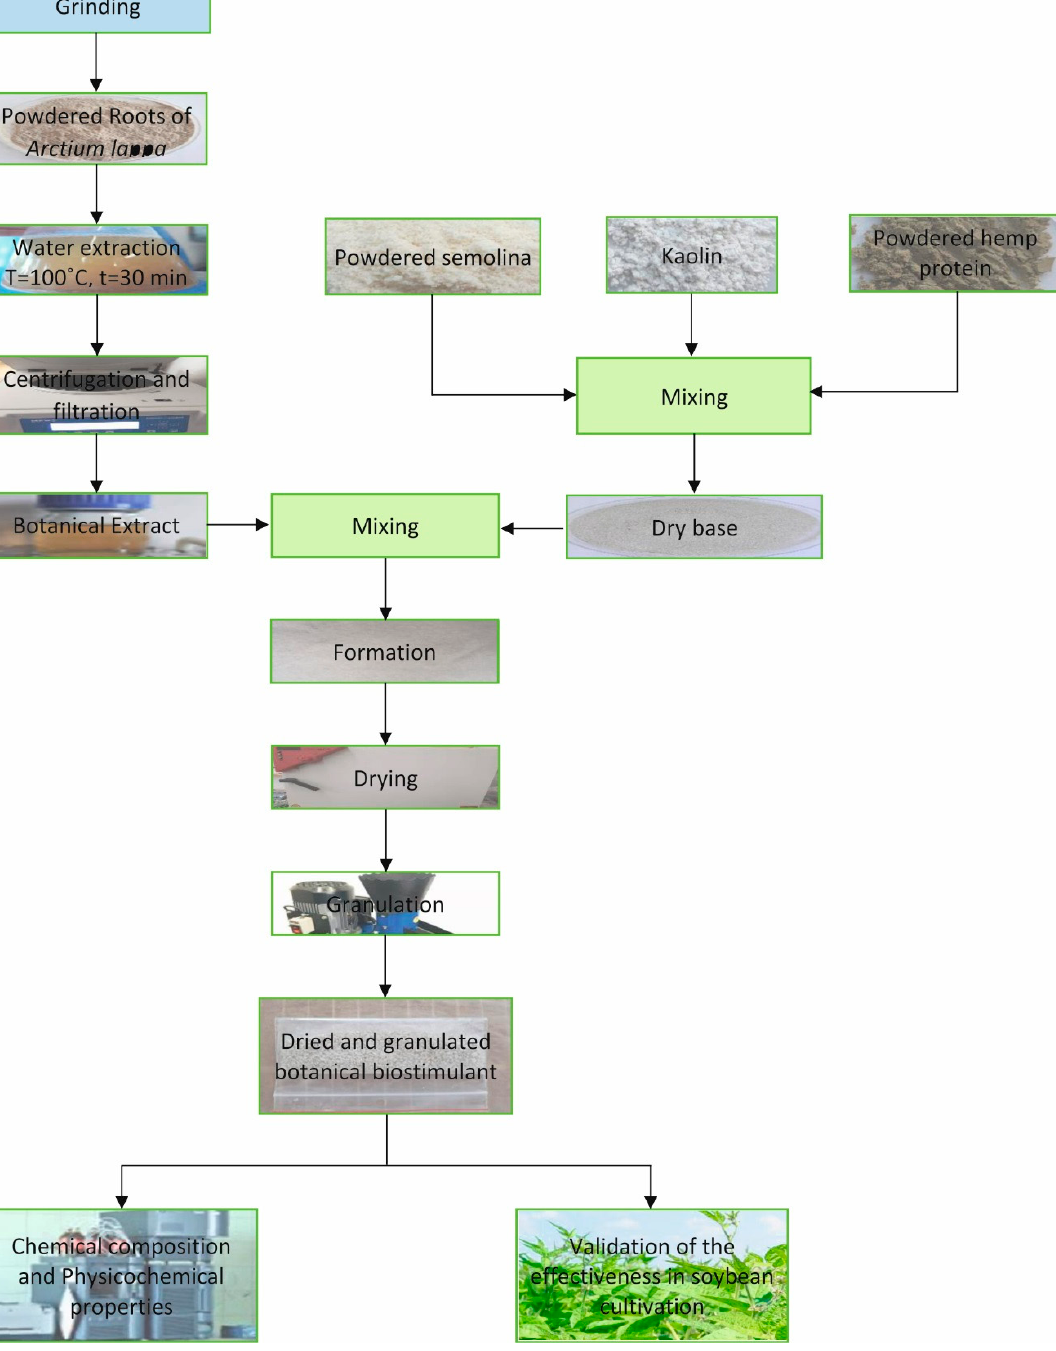
Figure 1. Proposed flowchart of botanical biomaterial production and validation.